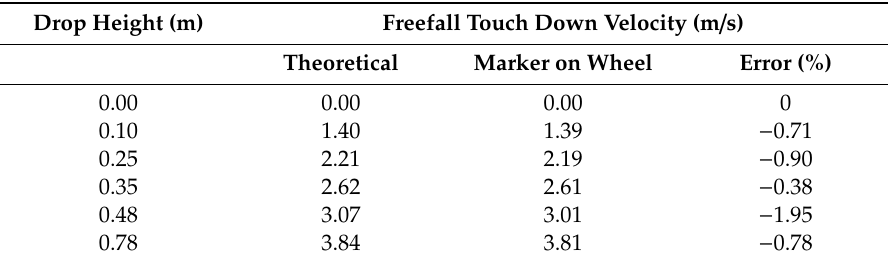
Table 1. List of drop experiments carried